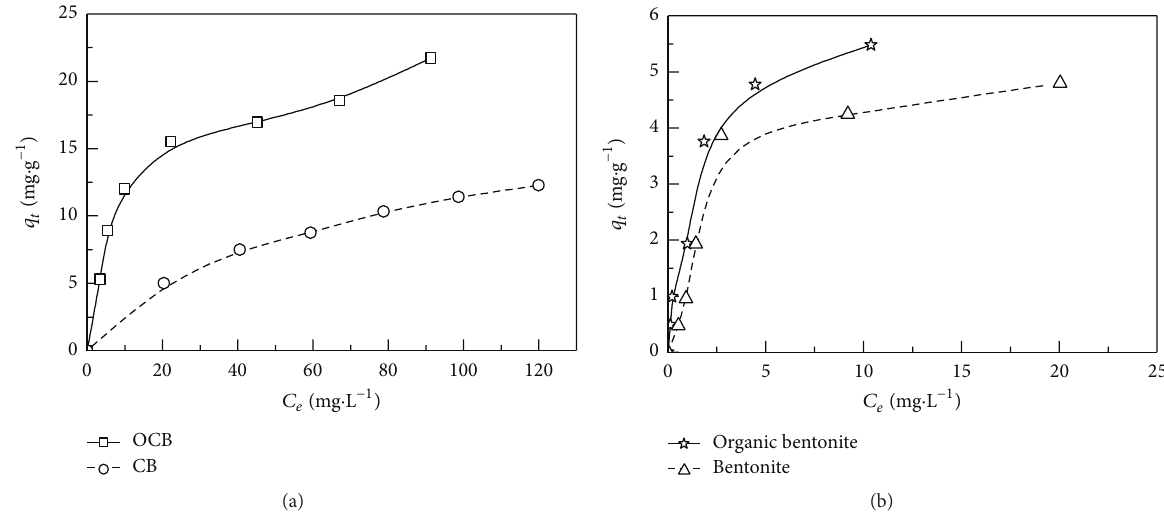
Figure 3: Sorption isotherms for the adsorption of Cu 2+ by CB, OCB, bentonite, and organic bentonite.